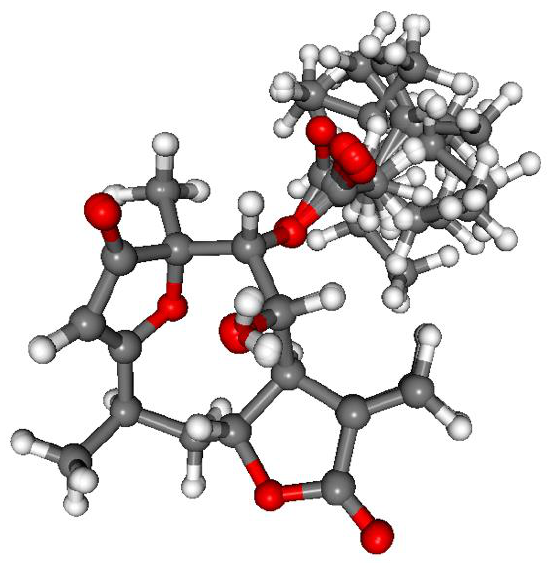
Figure 3. Overlapped geometries of the twelve low-energy CAM-B3LYP/TZVP PCM/MeCN con- formers of (4 R ,6 R ,7 R ,8 S ,9 R ,10 R )- 1 .